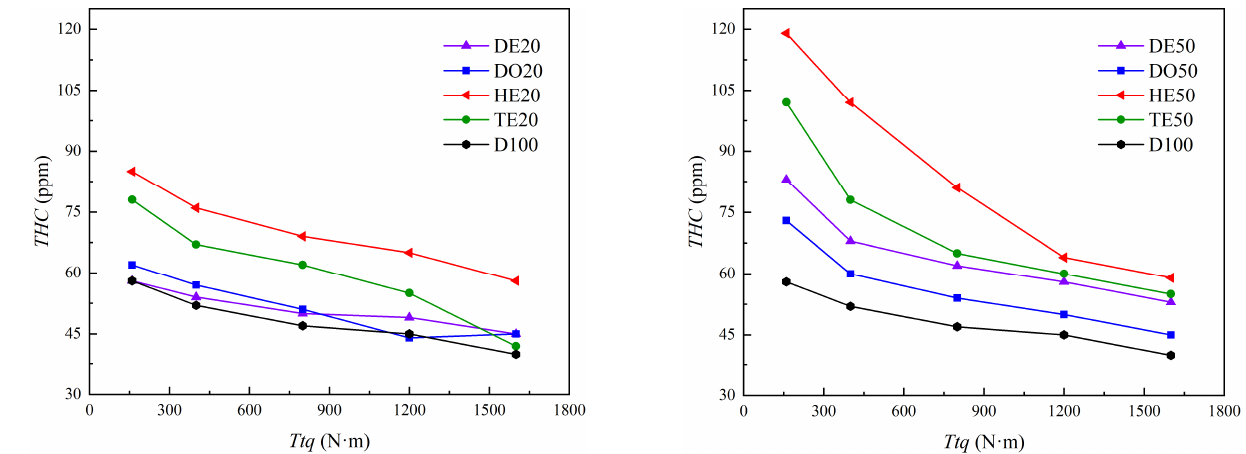
Figure 14. THC emissions versus engine loads at 1900 rpm.